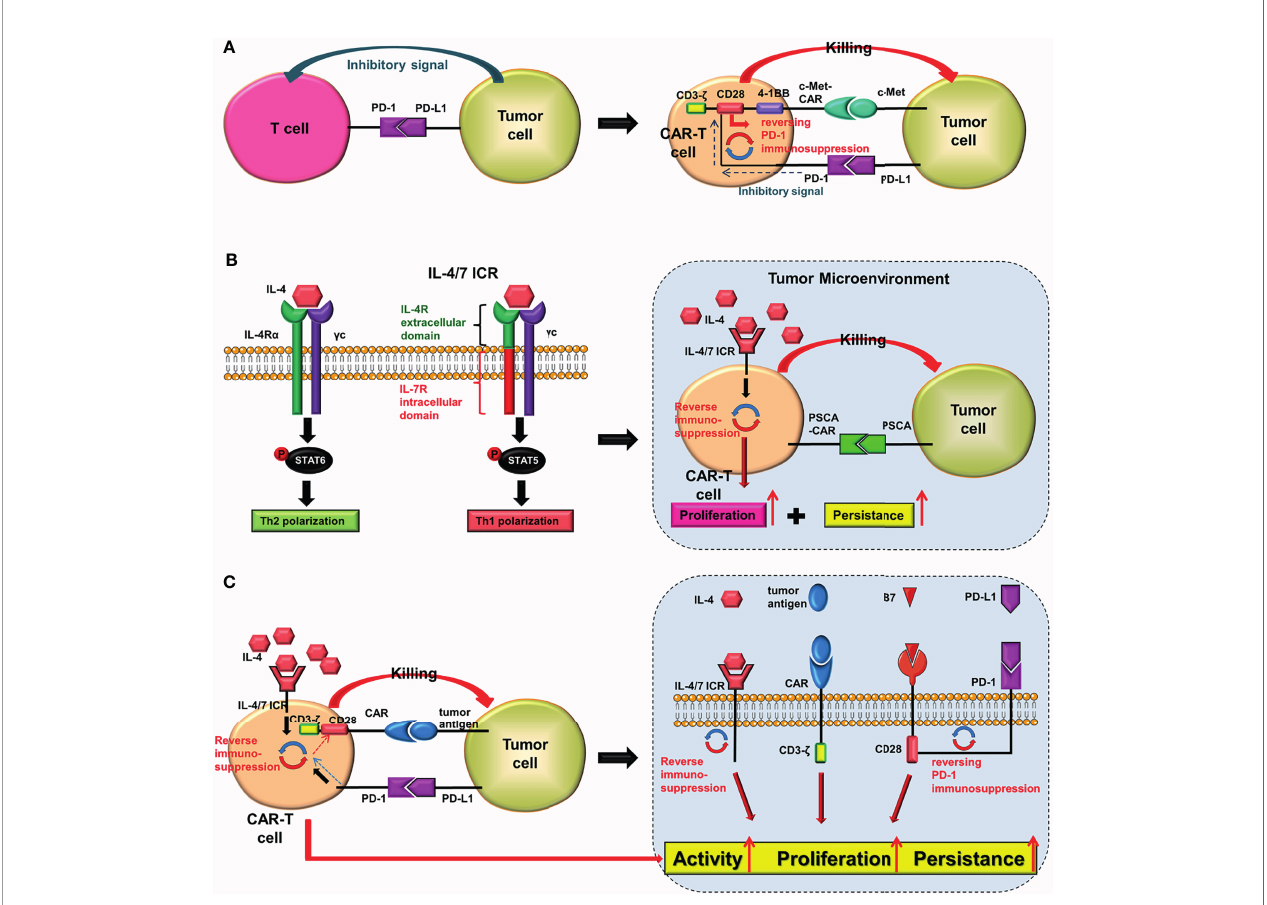
FIGURE 8 | PD-1/CD28 CSR and IL-4/7 ICR. In T cells: (A) the PD-1/CD28 CSR converts inhibitory signals delivered by PD-1 into activation signals, whereas (B) the IL-4/7 ICR converts inhibitory signals delivered by IL-4 into activation signals. The IL-4/7ICR can improve the proliferation and persistence of CAR-T cells in an IL-4-rich tumor microenvironment. (C) The PD-1/CD28 CSR and the IL-4/7 ICR are both injected into CAR-T cells